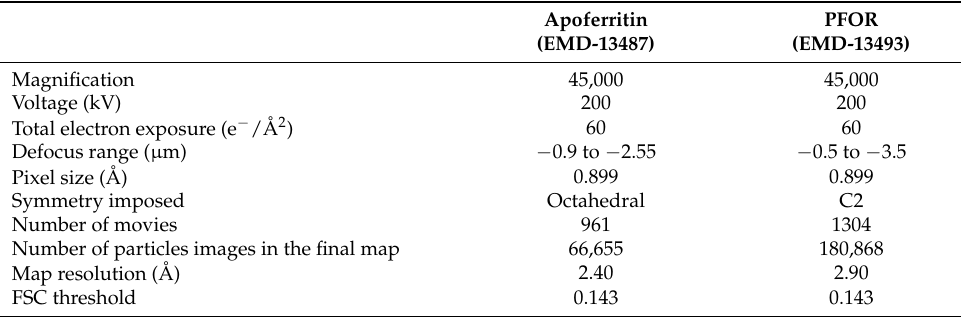
Table 1. Cryo-EM data collection and processing.